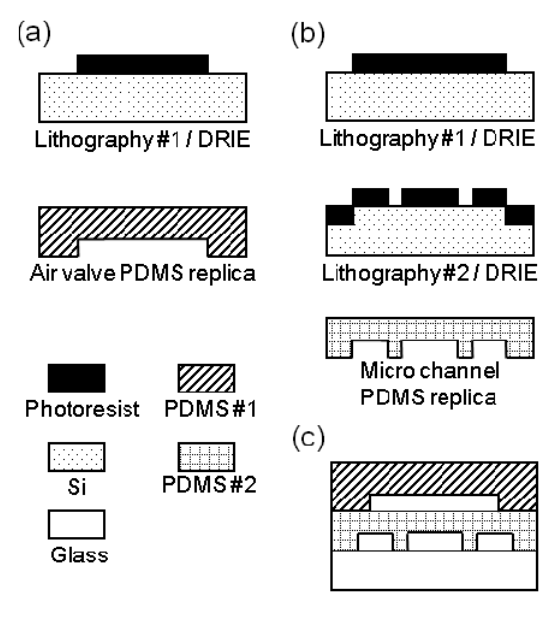
Figure 2. Schematic illustration of the fabrication process of the micro chip and the completed device. The manufacturing processes of (a) air valve replica and (b) micro channel